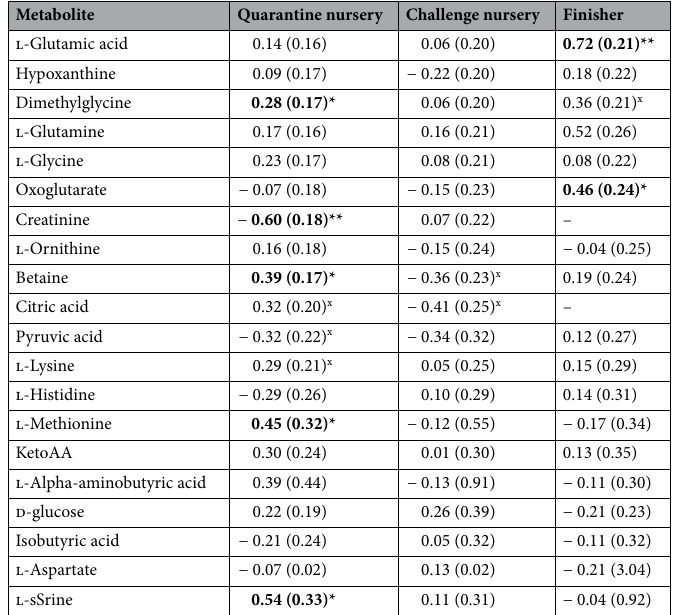
Table 2. Estimates (SE in parentheses) of genetic correlations between the most heritable metabolites and average daily gain in three stages, i.e. the quarantine nursery, the challenge nursery, and the finisher. Significance of genetic correlations are indicated in bold as: **, *, x corresponding to P < 0.01, P ≤ 0.05 and 0.05 < P < 0.10 respectively; “–” indicates not estimable.